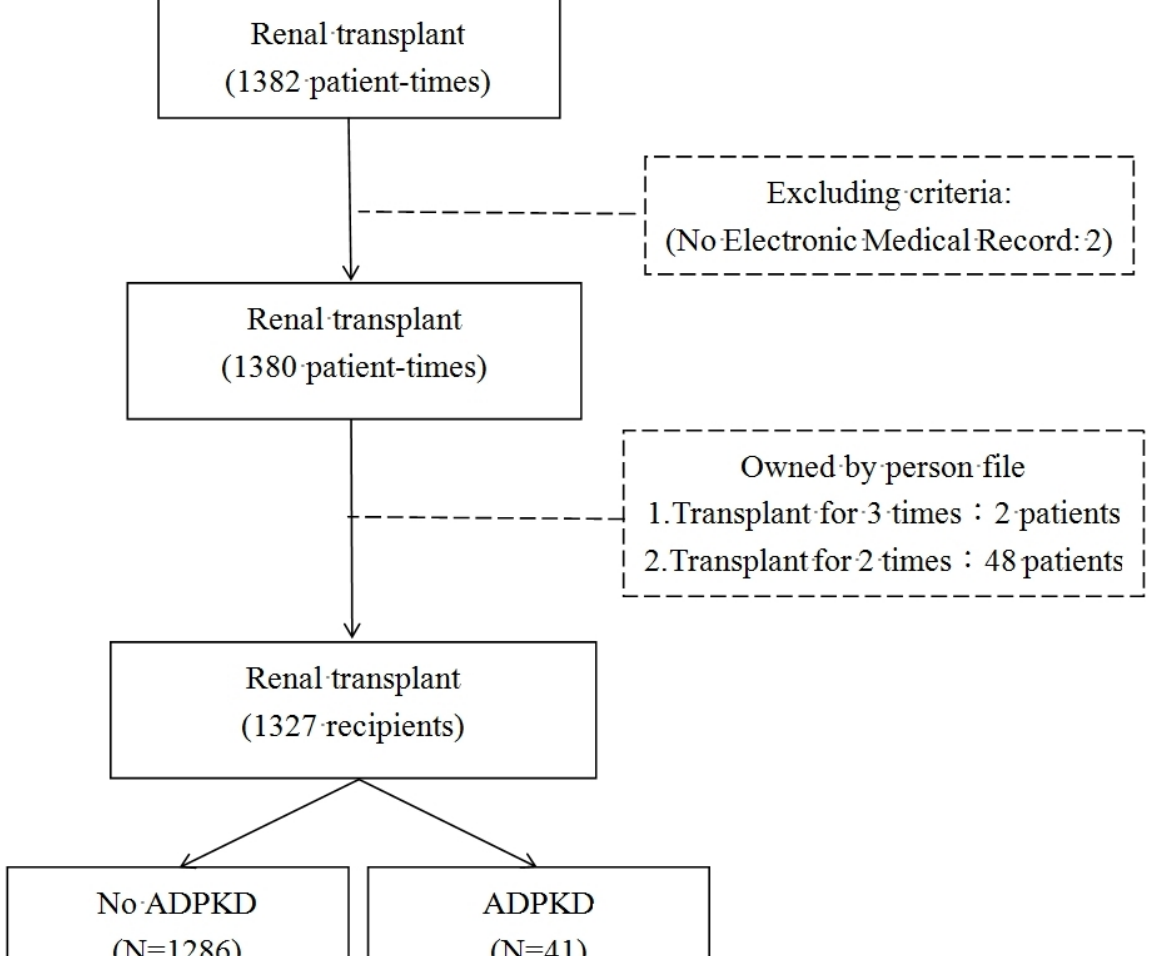
Figure 1. Flowchart of the renal transplant recipients for the ADPKD group and non-ADPKD group. Table 1. Baseline characteristics of renal transplantation recipients according to ADPKD or not